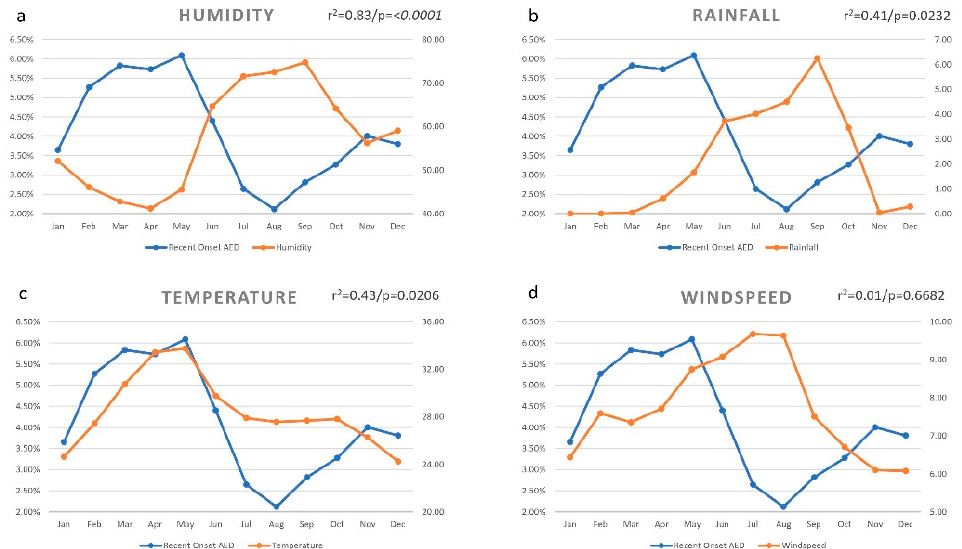
Figure 2. Monthly variation of environmental factors and the prevalence of recent onset allergic eye disease (AED) in the district of Hyderabad. The month-wise prevalence of AED was negatively correlated with the distribution of humidity (( a ) r = − 0.9148) and rainfall (( b ) r = − 0.6462), and positively correlated with temperature (( c ) r = 0.6558) but not with windspeed (( d ) r = − 0.1383).